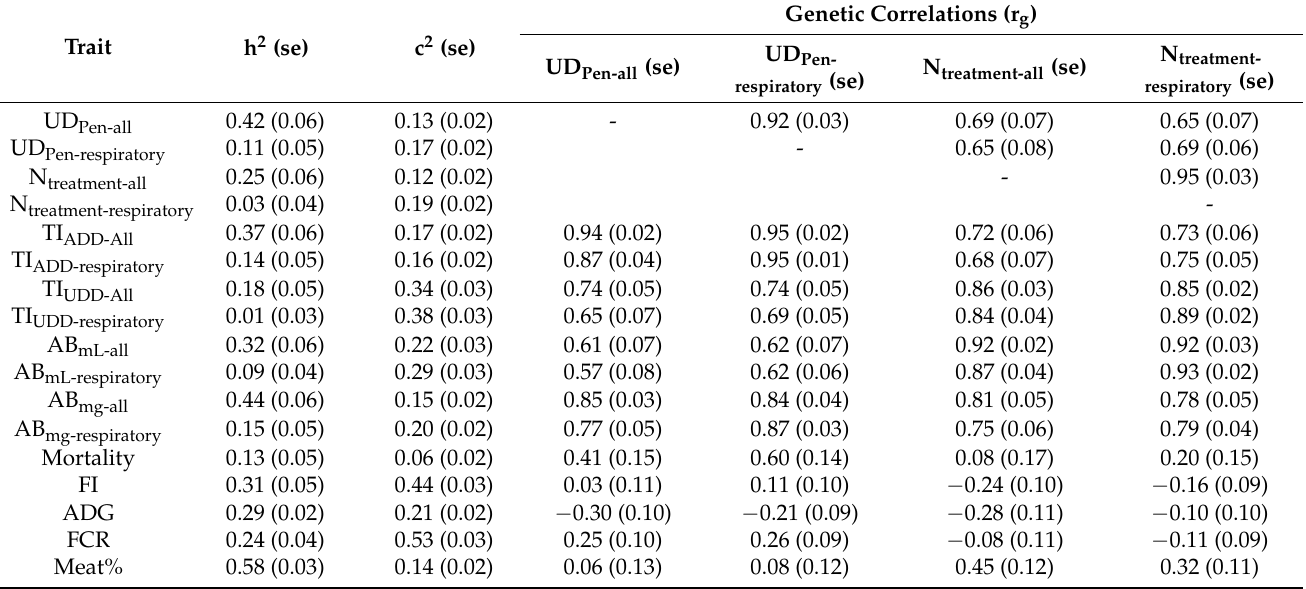
Table 3. Genetic parameters for the antibiotic usage traits (pen level) and production traits (individual/pen level). Heritabil- ities (h 2 ), common environmental effects (c 2 ) and genetic correlations (r g ; bivariate) were calculated.